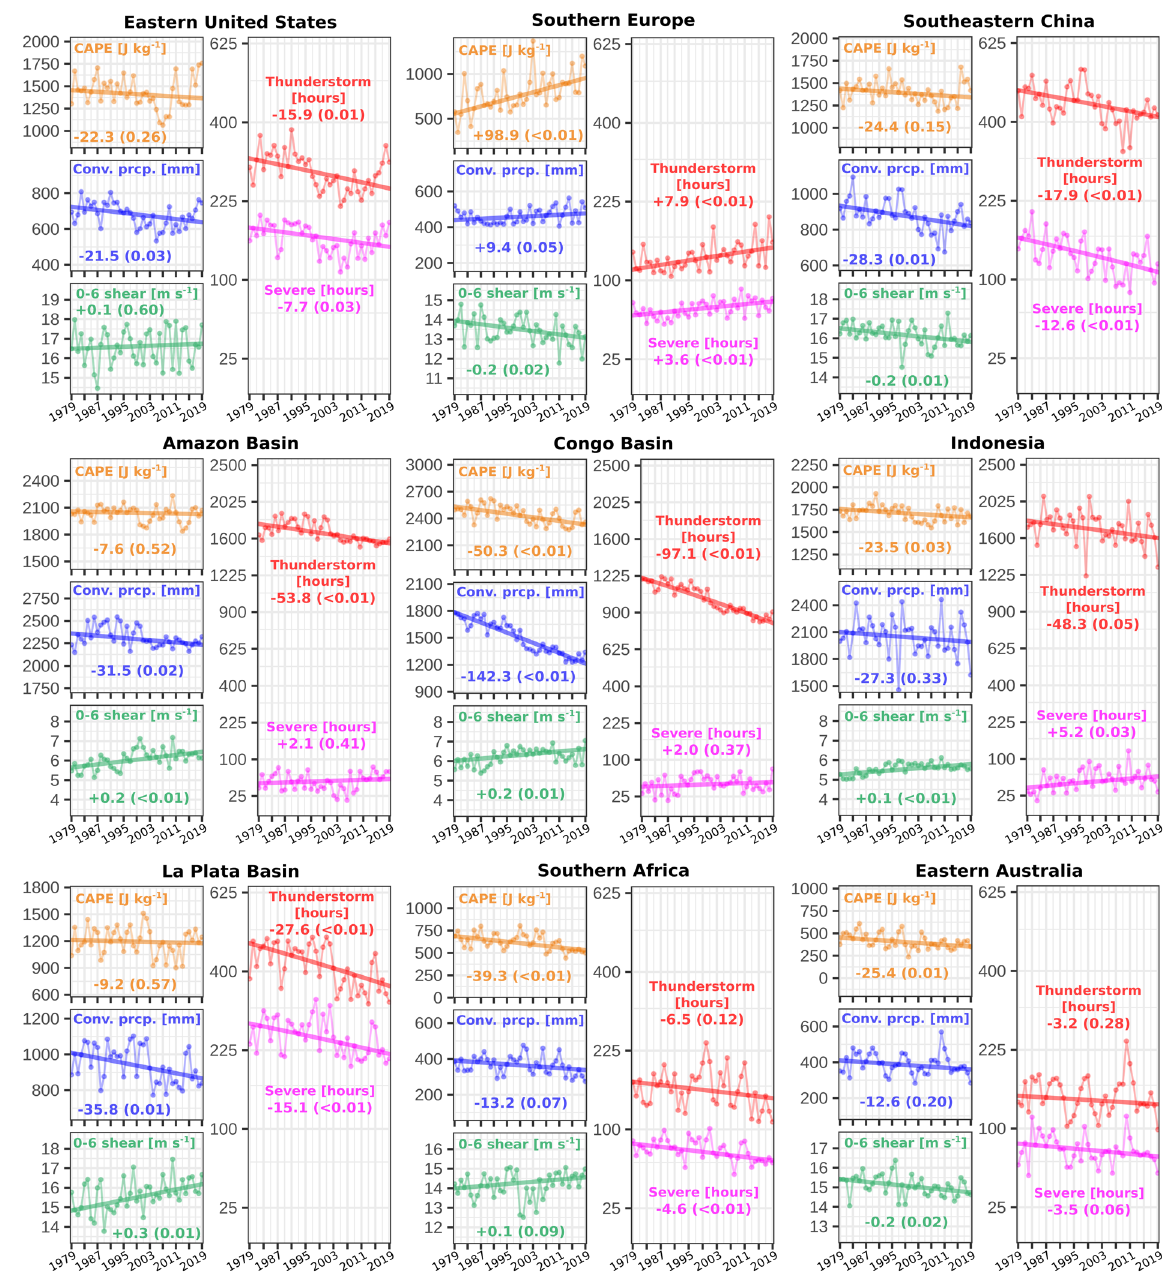
Fig. 3 ERA5 regional trends for CAPE, convective precipitation, vertical wind shear, thunderstorm, and severe thunderstorm environments. A 41-year (1979 – 2019) annual distribution of the (orange) 95 th percentile of convective available potential energy (CAPE), (blue) accumulated convective precipitation, (green) 50 th percentile of 0 – 6 km vertical wind shear, (red) frequency of thunderstorm environments, and (magenta) frequency of severe thunderstorm environments for speci fi c regions (areal mean) as indicated on Supplementary Fig. 6. Trends are computed using Sen ’ s slope and indicated as a solid line. Numbers within linear plots indicate trend per decade and p